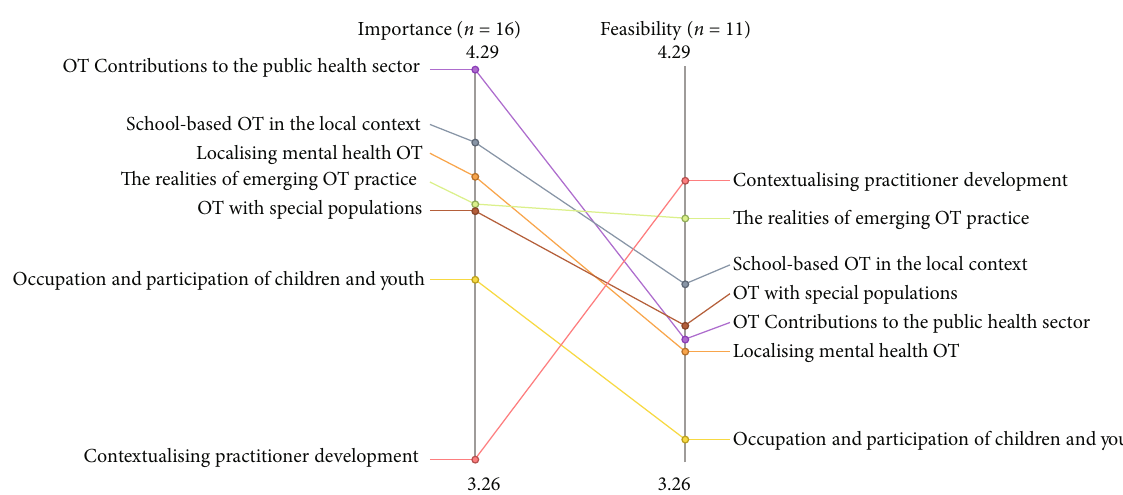
Figure 3: Pattern match comparing the mean importance and feasibility rating scores at cluster level. Clusters with higher mean scores are located closer to the top of the pattern match ( r = − 0 : 41